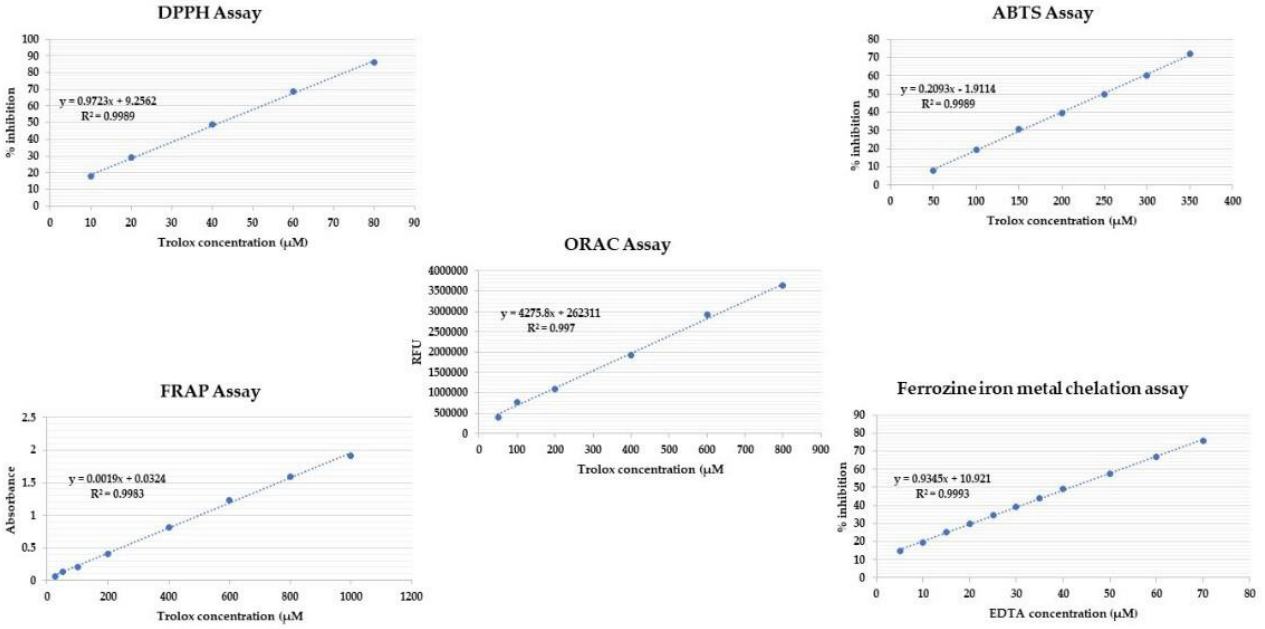
Figure 3. Standard calibration curves of the antioxidant assays expressed as Trolox and EDTA .